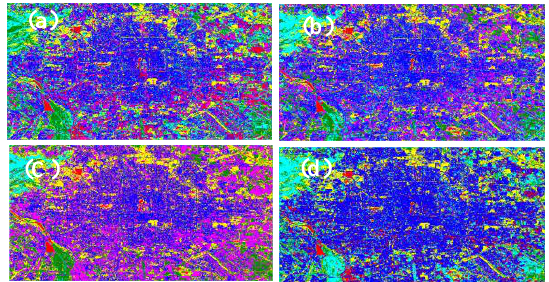
Figure 1. Geographical location of the study area